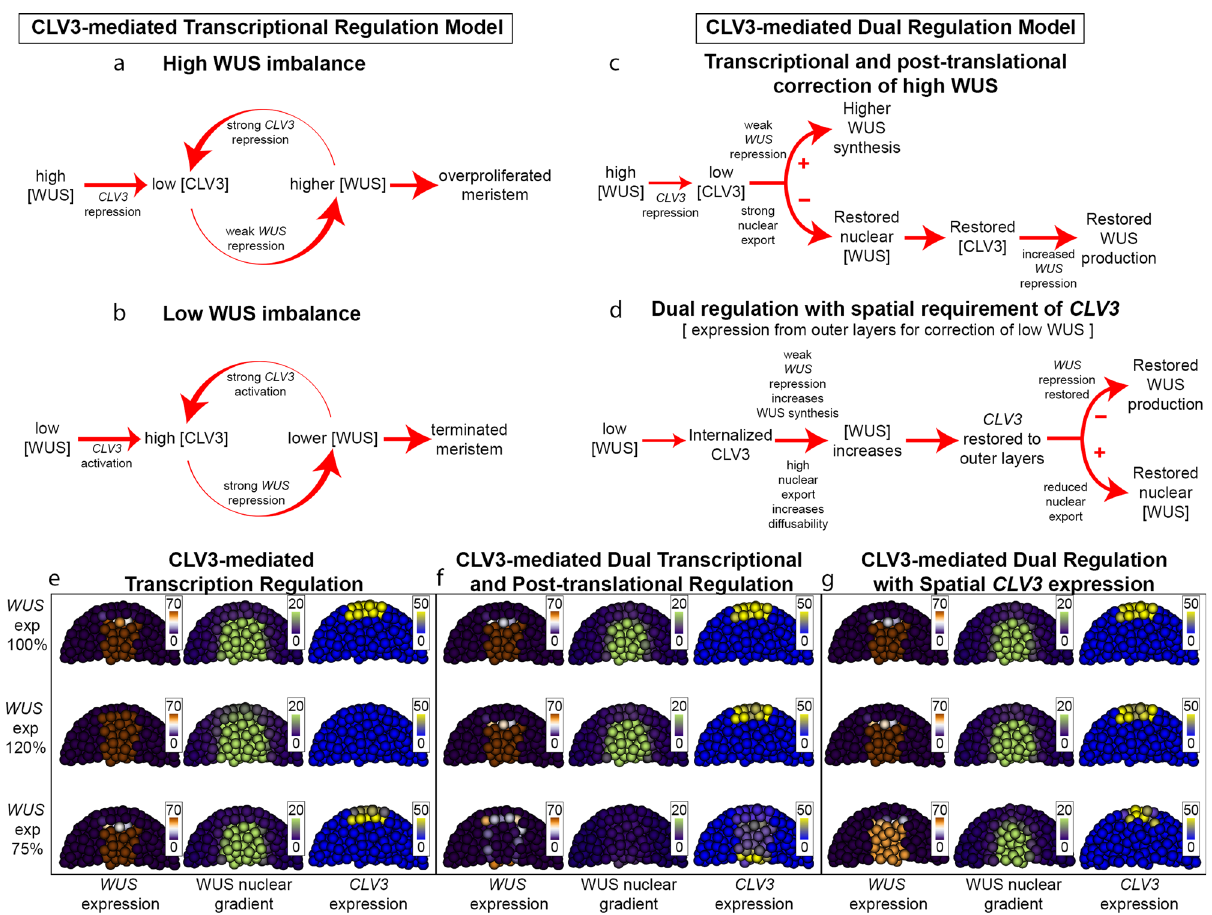
Fig. 6 Dynamics of WUS-CLV3 feedback in simulations with CLV3-mediated transcriptional regulation, dual transcriptional and post-translational regulation, and dual regulation with the spatial requirement of CLV3 expression from the outer layers, upon perturbing the WUS expression rate. a In the transcriptional regulation model, high WUS concentration represses CLV3 , which relieves WUS repression leading to more WUS production. b Low WUS concentration in the transcriptional regulation model activates CLV3 which continues to suppress WUS expression, lowering WUS levels. c In contrast in the CLV3-mediated dual regulation model, high WUS leads to low CLV3 which leads to increased nuclear export decreasing the nuclear concentration and increased WUS synthesis generating new WUS molecules. d Low WUS levels in the dual regulation model with the spatial requirement of CLV3 expression from the outer cell layers leads to internalization of CLV3 that is less potent in repressing WUS and reducing nuclear export which leads to increased synthesis of diffusible cytoplasmic WUS to restore WUS levels in the outer layers. With WUS levels restored, CLV3 expression gets restored back to the outer layers which in turn reduces the nuclear export of WUS in the outer layers to restore WUS production and the nuclear WUS concentration. e – g WUS expression (brown), the WUS nuclear protein gradient (green), and CLV3 expression (yellow) in the SAM upon perturbations in